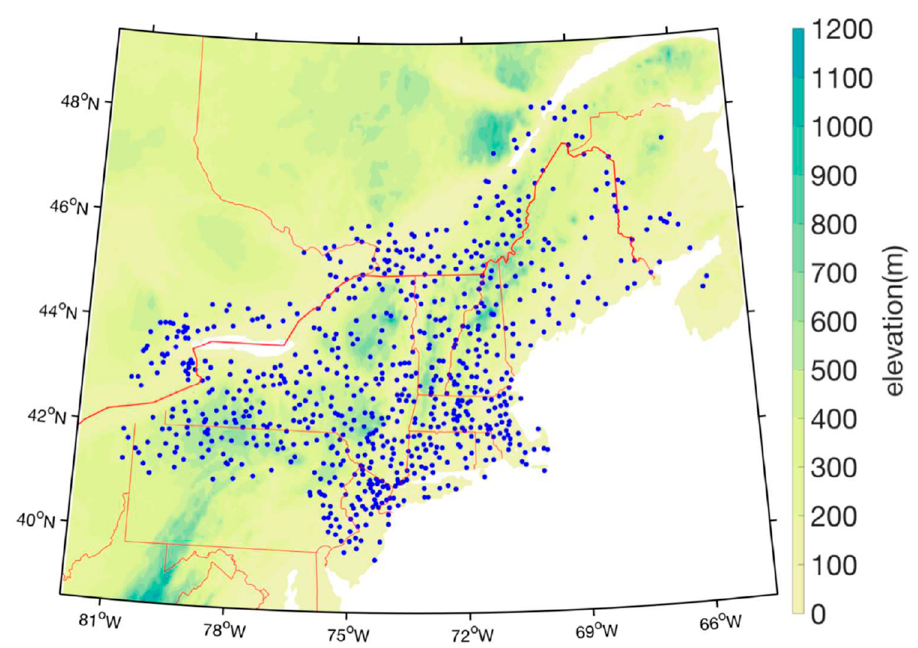
Figure 1. A map of the 753 selected stations in the Northeastern US. Shading represents elevation.